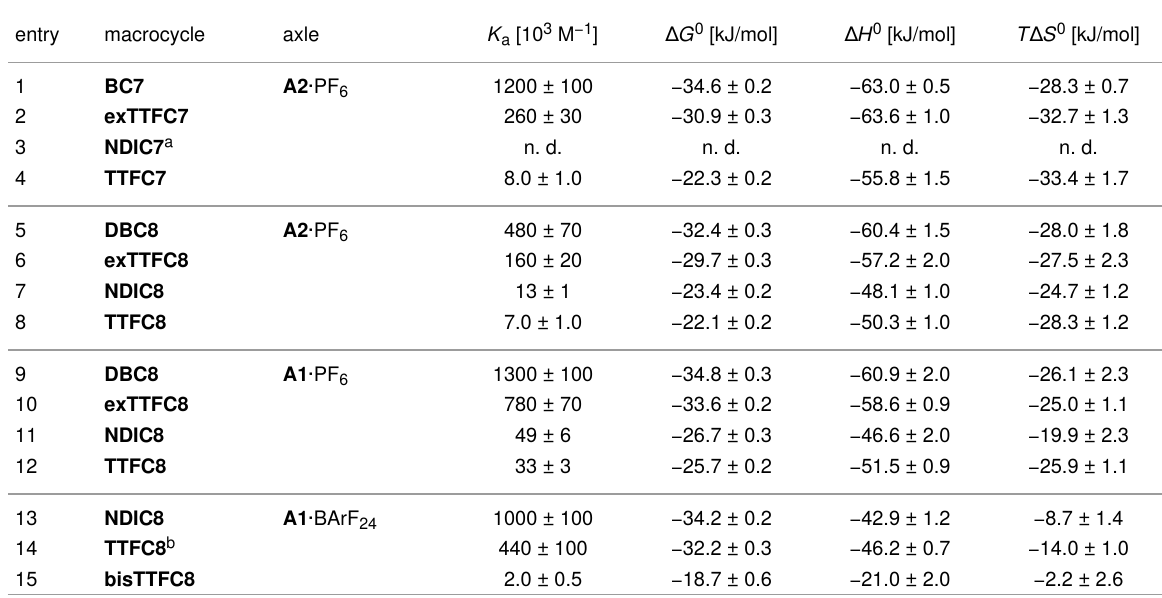
Table 1: Thermodynamic binding data of different crown ether/secondary ammonium axle complexes obtained by ITC titrations in DCE at 298 K (for full data set and titration curves, see Supporting Information File 1, section